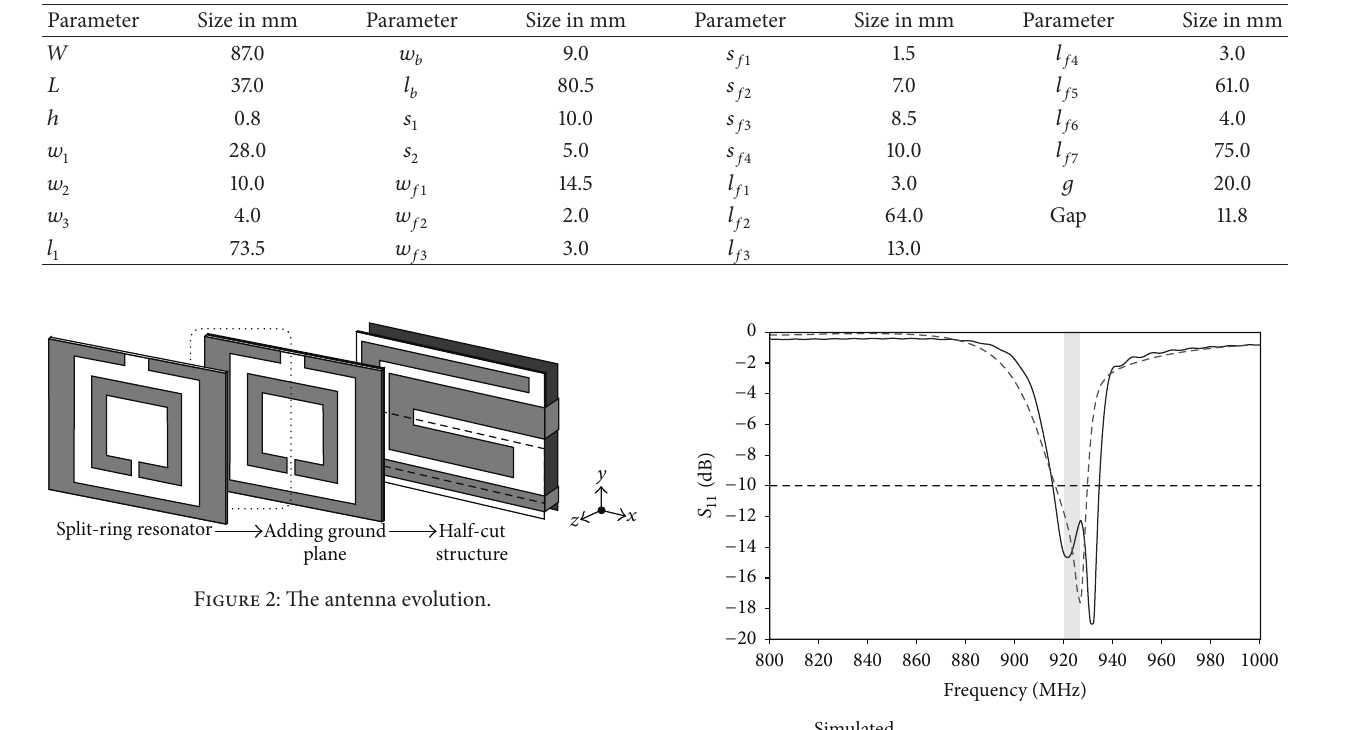
Table 1: The optimized structural parameters.